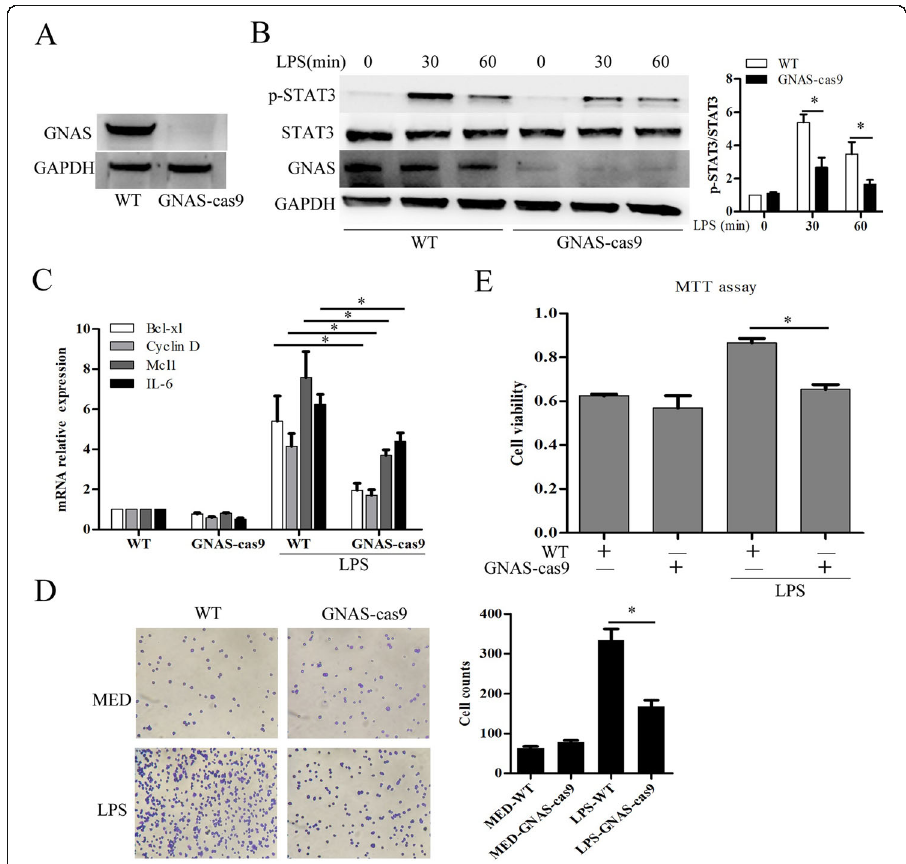
Fig. 4 GNAS promotes LPS-induced HCC cell growth and invasion. a Protein expression levels of GNAS in wild type HepG2 cells or GNAS knockout-HepG2 cells were detected by Western blotting. b HepG2 cells or GNAS knockout-HepG2 cells were treated with LPS (5 μ g/ml) or not for the indicated hours. Then, the protein expression levels of STAT3, p-STAT3, and GNAS were detected by Western blotting. c , d and e HepG2 cells or GNAS knockout-HepG2 cells were treated with LPS (5 μ g/ml) or not for 12 h. Then, the mRNA expression levels of the indicated genes were detected by qRT-PCR ( c ). Cell invasive ability was examined by transwell invasion assays ( d ). Cell proliferation was examined by MTT assays ( e ). Data are represented as means ± SD ( n = 3; * represents P <